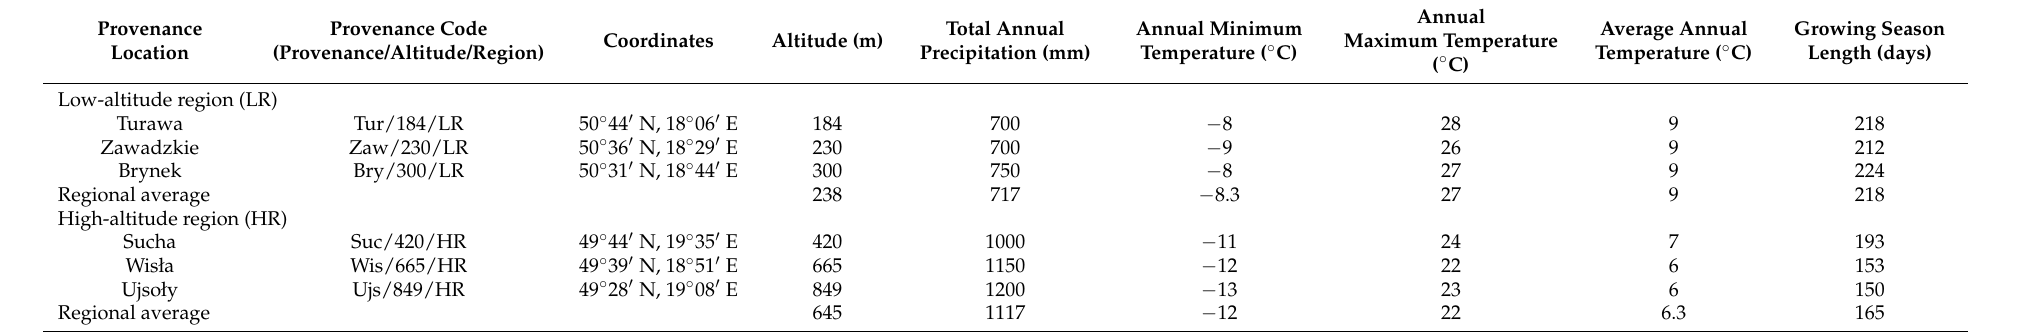
Table 1. Coordinates, altitude and climatic conditions of the provenance locations of beech trees ( Fagus sylvatica L.). Data is from the Institute of Meteorology and Water Management, National Research Institute from 2003–2013.